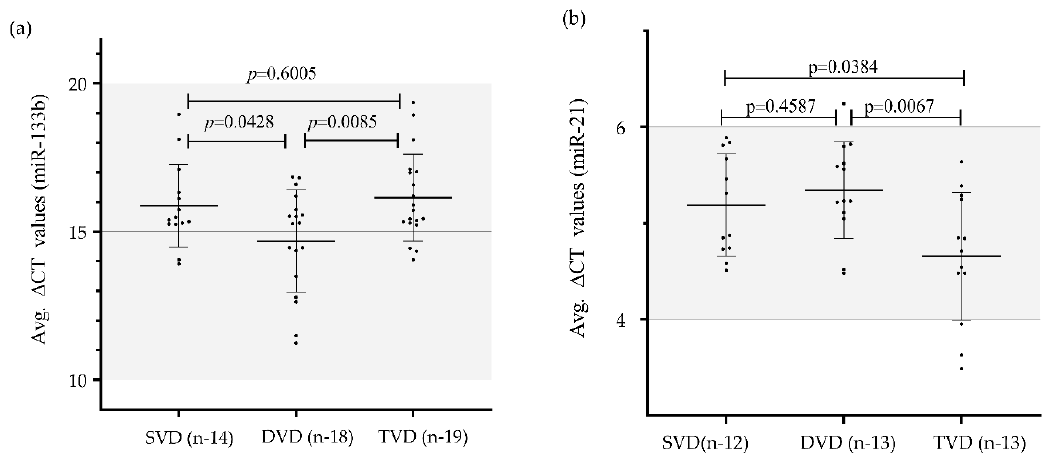
Figure 5. Mean expression values (delta-CT values) of miR-133b and miR-21 in different categories based on diseased vessels involved in CAD patients: ( a ) Differential gene expression (delta-CT values) of miR-133b in different categories of CAD based on diseased vessels involved vs. control subjects. Lowest expression of miR-133b was obtained in TVD (16.15 ± 1.47; n = 19) as compared to DVD (14.68 ± 1.72; n = 18) and SVD (15.88 ± 1.39; n = 14). TVD vs. DVD ( p value = 0.0085) and DVD vs. SVD ( p -value = 0.0428) showed a significant difference for miR-133b except SVD vs. TVD ( p -value = 0.6005); ( b ) Differential gene expression (delta-CT values) of miR-21 in different categories of CAD based on diseased vessels involved vs. control subjects. Results are expressed as mean ± SD. Highest expression of miR-21 was obtained in TVD (4.66 ± 0.67; n = 13) as compared to DVD (5.27 ± 0.44; n = 13) and SVD (5.34 ± 0.63; n = 12). TVD vs. DVD ( p -value = 0.0067) and TVD vs. SVD ( p -value = 0.0384) showed a significant difference for miR-133b except SVD vs. DVD ( p -value = 0.4587). Results were expressed as mean ± SD. One-way analysis of variance followed by Bonferroni correction for multiple comparisons was applied to assess the miRNA expressions among the subcategories. p -value < 0.05 is considered to be significant.